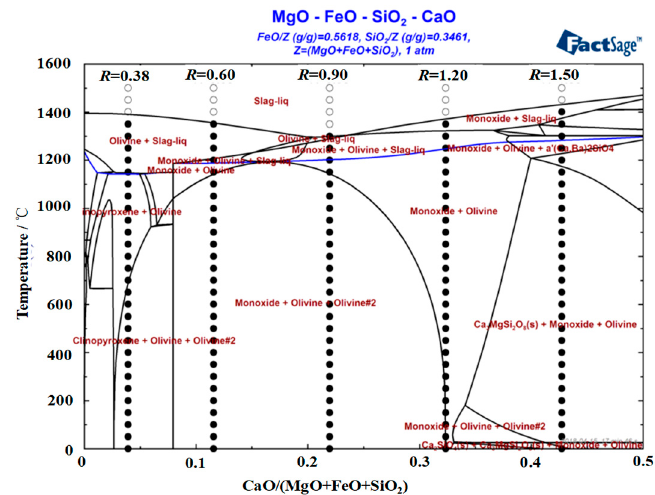
Figure 4. Phase diagram of a CaO-SiO 2 -FeO-MgO slag system in an argon atmosphere.